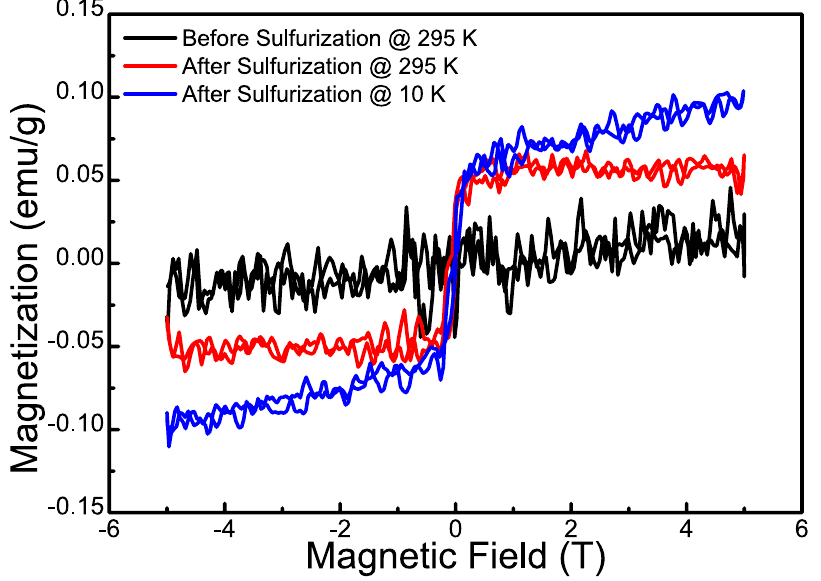
Figure 7. Magnetic hysteresis loop of pristine MoO 3 and sulfurized MoO 3 at different temperatures.